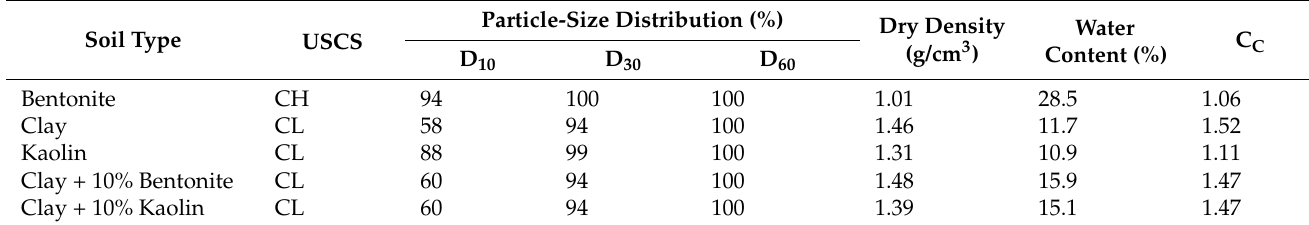
Table 1. The physiomechanical properties of the studied clayey soil.